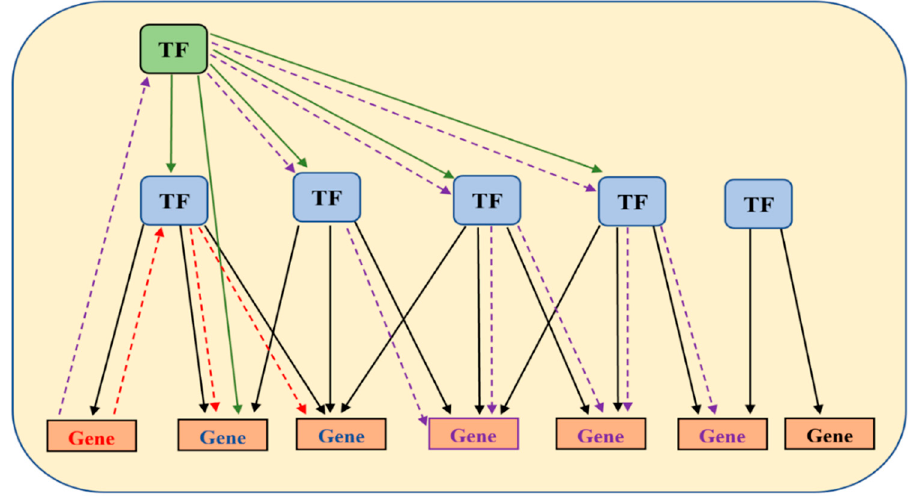
Figure 2. A hypothetical map illustrating TF network hierarchy. A master transcription factor is highlighted with green background. Other transcription factors are highlighted using blue-filled shapes. A red gene depicts a ‘seed’ marker gene known to be involved in a disease (CRC in our case). The red dashed lines with arrows indicate the approach to discovering potentially co-regulated genes (blue) that share the same upstream transcription factor(s). Identification of a master transcription factor (purple dashed line) may lead to discovery of other relevant TFs and of other genes (purple).